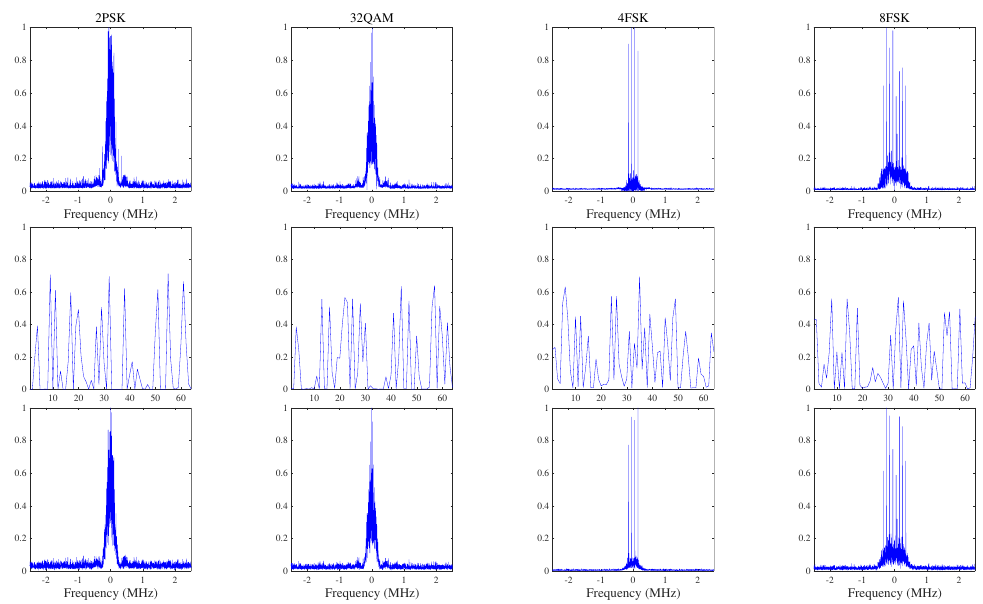
Figure 4. Welch spectrums, SAE features and decoding results under white Gaussian noise (SNR = 0 dB). Let ˜ a ( n ) and ˜ φ ( n ) be the centered instantaneous amplitude and phase, respectively, defined